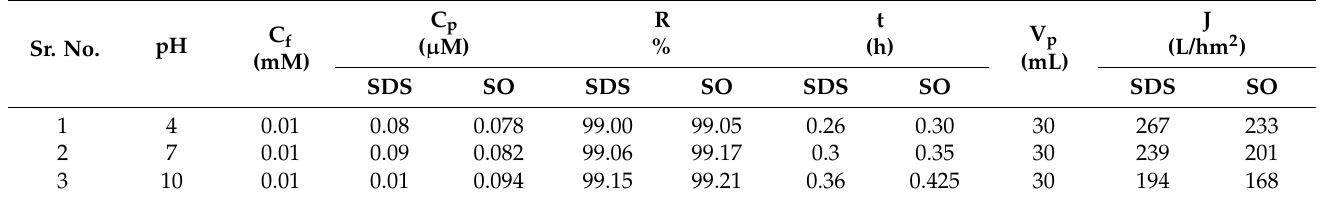
Table 6. Calculation of rejection coefficient (R%) and permeate flux (J) of Co 2+ against different pH values, in solution of SDS and SO at fixed Co 2+ concentration in feed (C f ), Co 2+ concentration